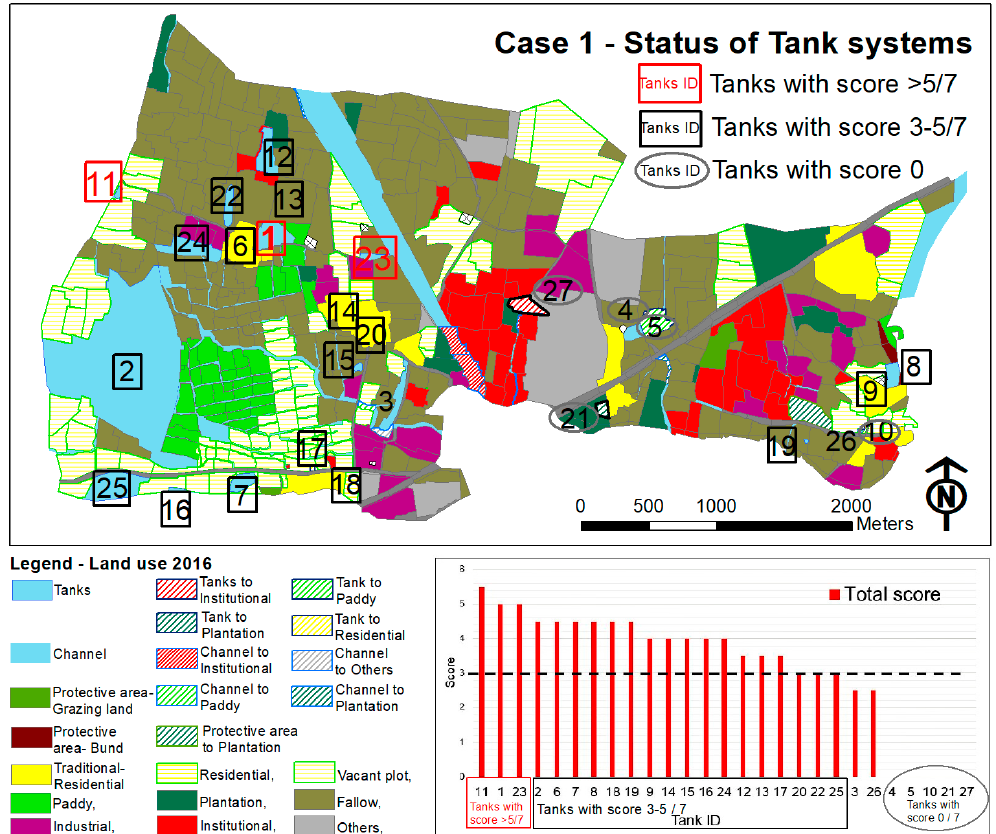
Figure 13. Relationship between change in agricultural land use and the status of the tank systems in case 1.